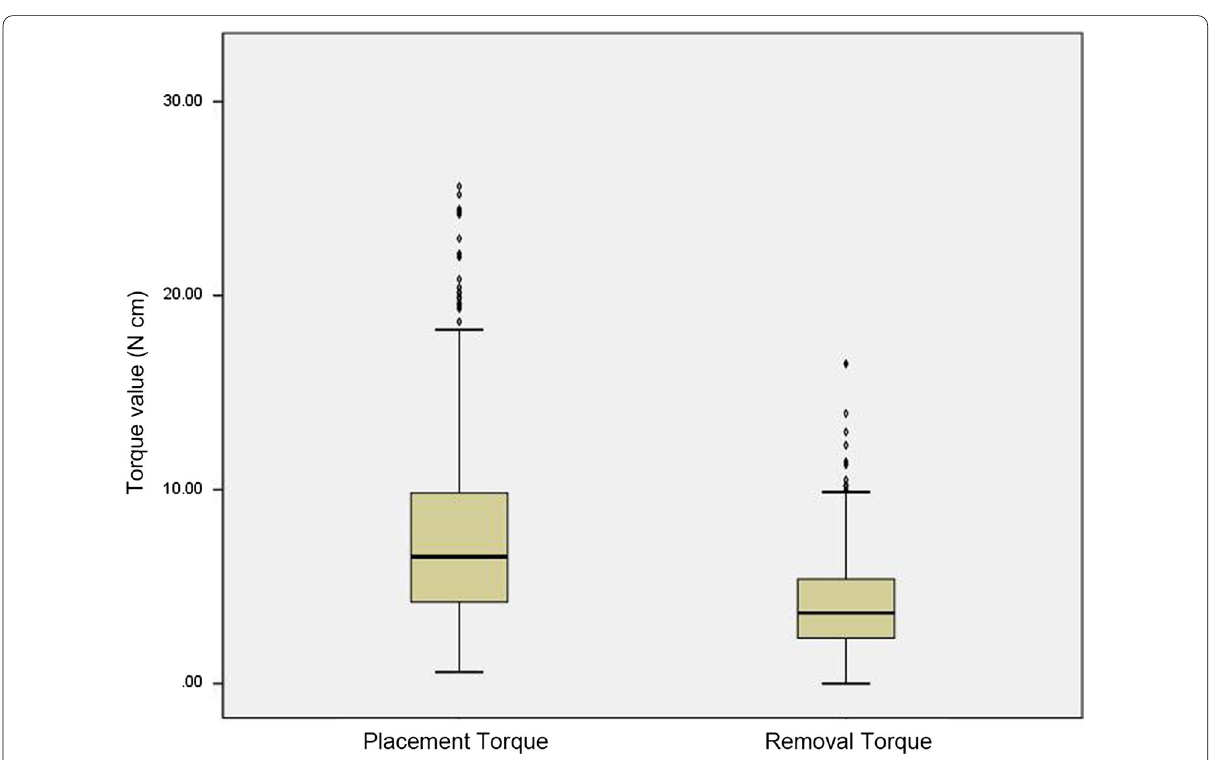
Fig. 4 Box plot of the distribution of the total placement and removal